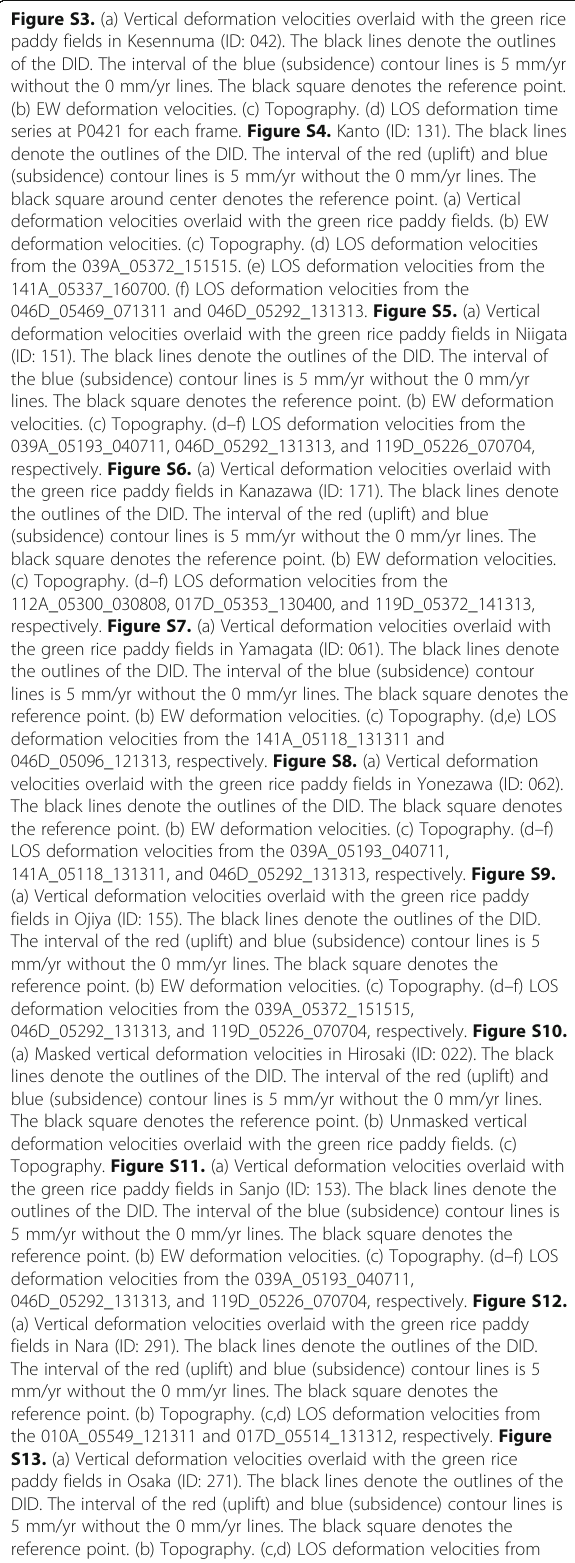
S14. (a) Vertical deformation velocities overlaid with the green rice paddy fields in Kumamoto (ID: 431). The black lines denote the outlines of the DID. The interval of the red (uplift) and blue (subsidence) contour lines is 5 mm/yr without the 0 mm/yr lines. The black square denotes the (c) Topography. (d – f) LOS deformation velocities from the 054A_05688_051313, 156A_05639_121313, and 163D_05736_131313, re- spectively. Table S1. LiCSBAS parameter settings used in this study. The name of the parameters are explained in the LiCSBAS script (https://